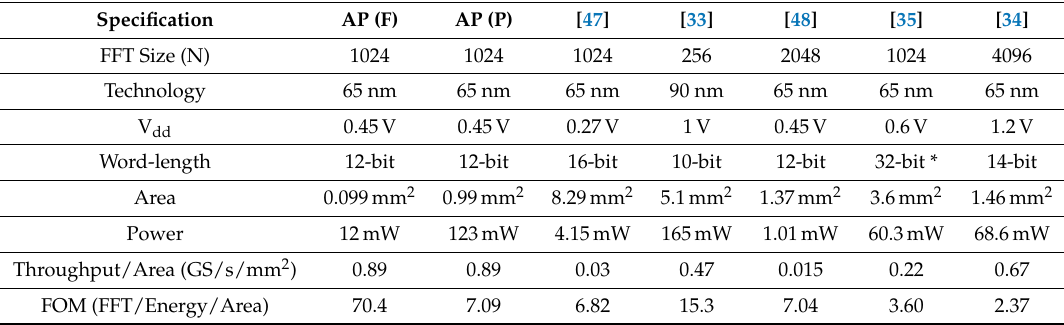
Table 3. Comparison of FFT Processors without normalization.